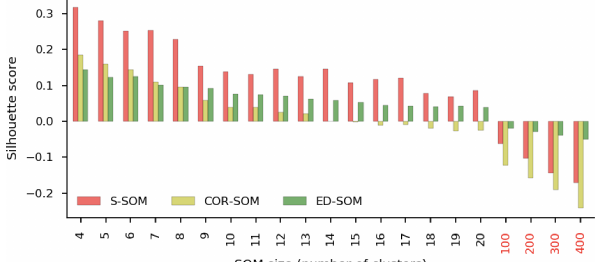
Figure A10. Average silhouette scores of S-, COR-, and ED-SOM. The x axis indicates the SOM size configurations. The y axis shows the silhouette score, which ranges from − 1 to 1. For a given sample, the perfect cluster assignment has the value of 1, and negative values indicate the wrong cluster assignment for the